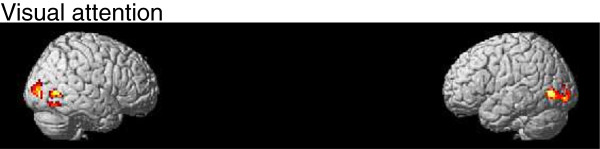
Visual attentional effect (visual attented relative to visual unattended contrast, p<0.005, spatial extent=20 voxels, T=3.11).